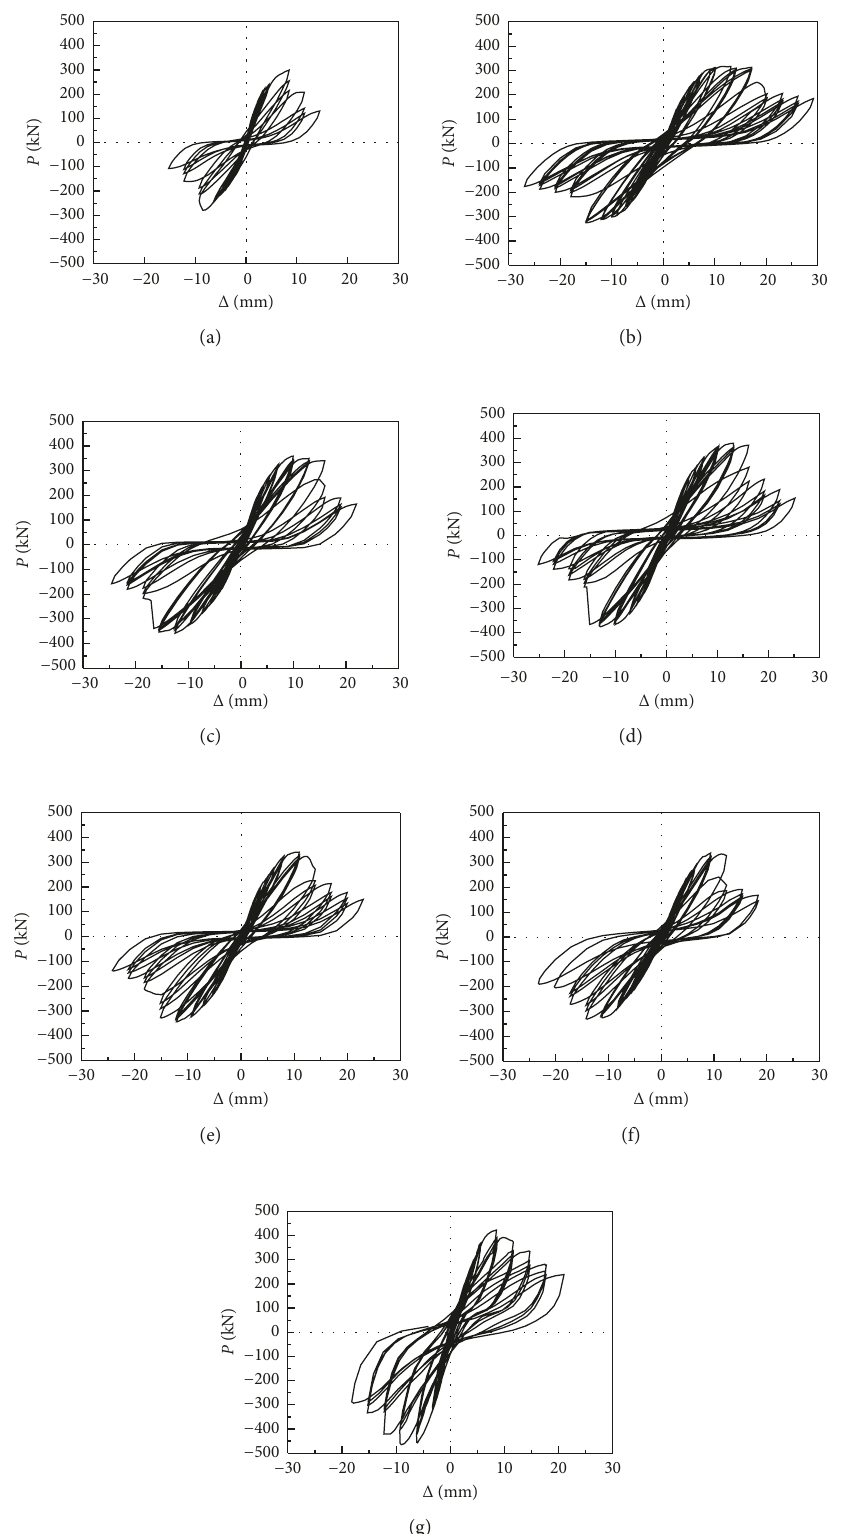
Figure 8: Hysteretic loops of specimens: (a) specimen RC1, (b) specimen HDC2, (c) specimen HDC3, (d) specimen HDC4, (e) specimen HDC5, (f) specimen HDC6, and (g) specimen